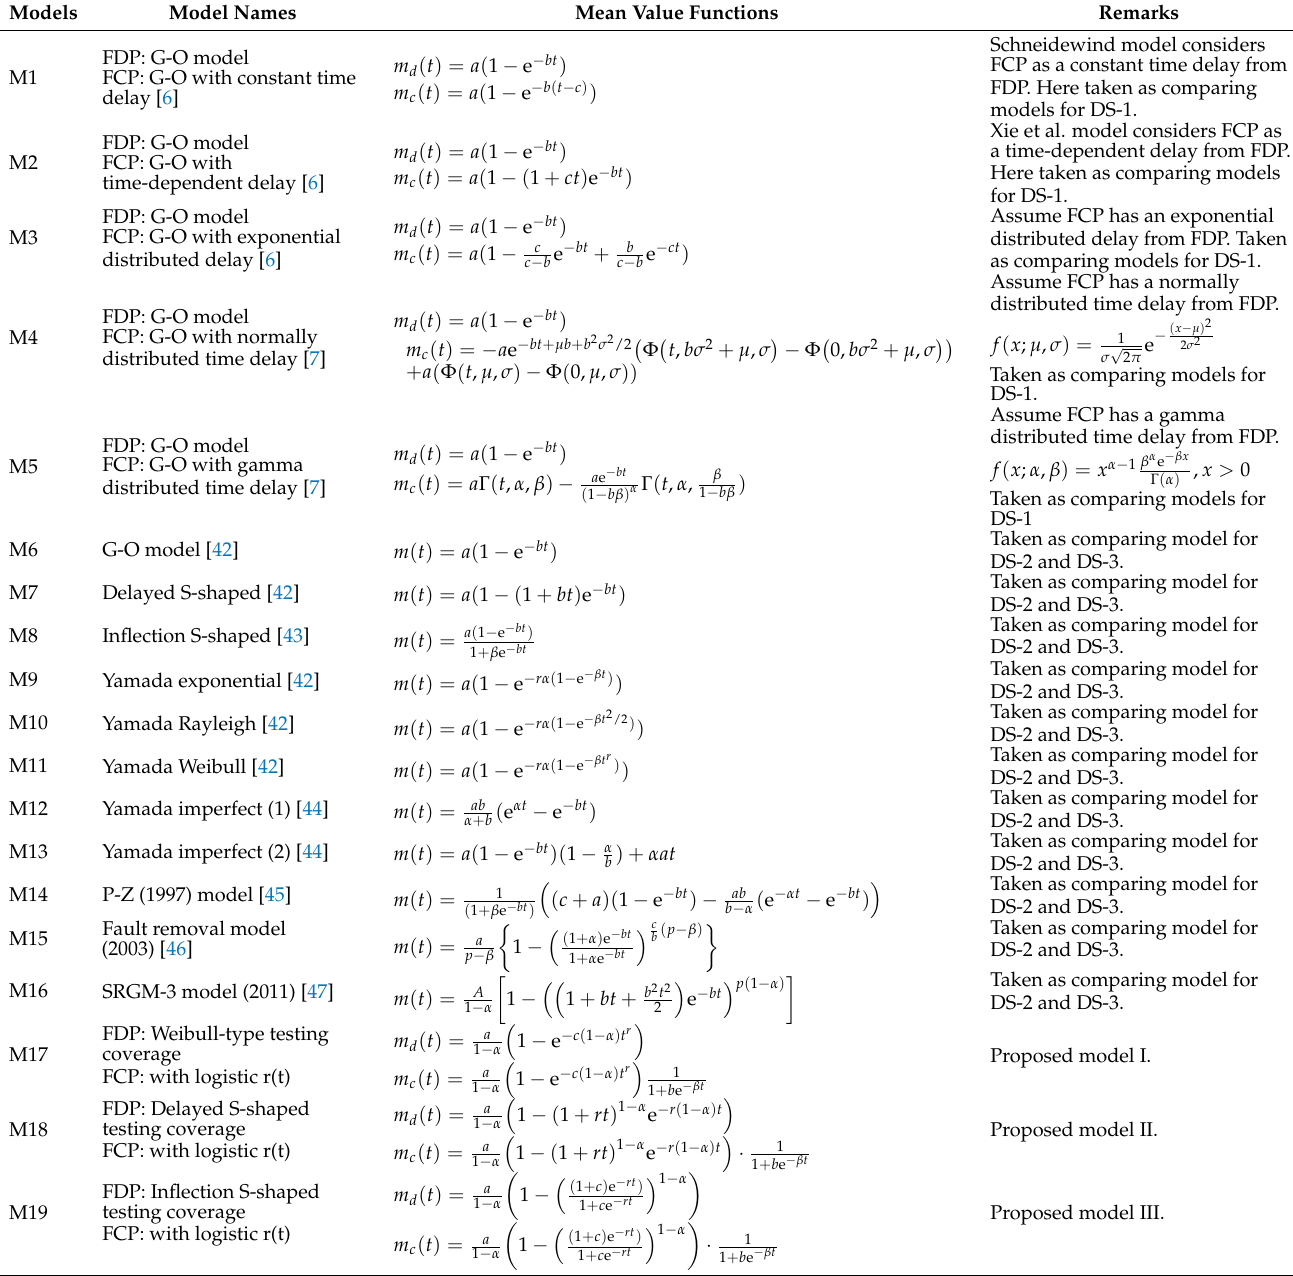
Table 2. Summary of